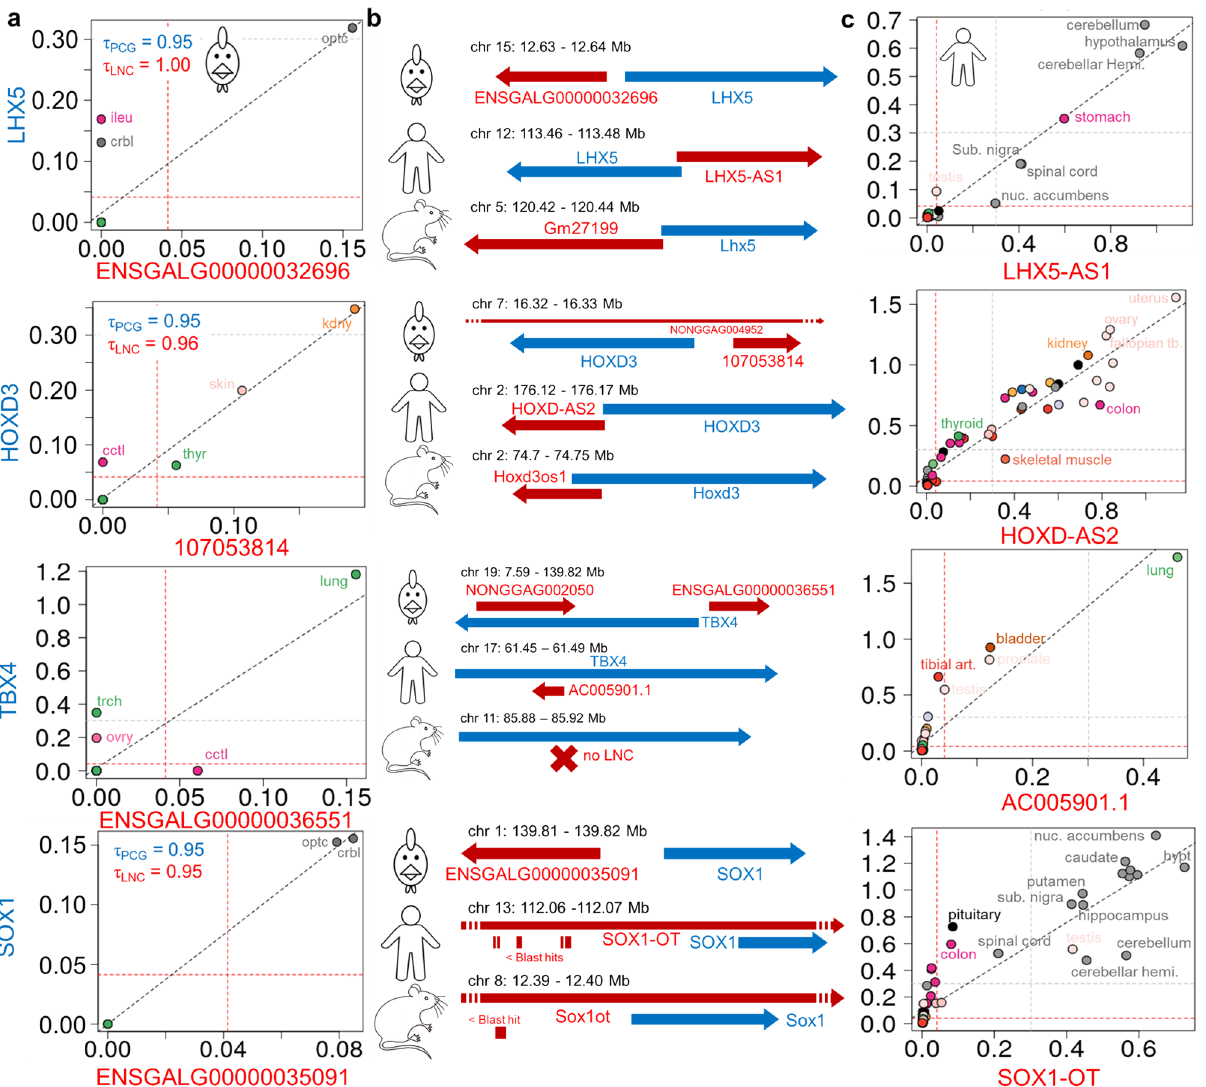
Figure 6. Tissue expression in chicken ( a ) and human ( c ) for 4 LNC:PCG pairs with similar genomic configurations between the two species ( b ). ( a ) Log 10 (TPM + 1) expression of the LNC (X-axis) and the PCG (Y-axis) (top) for chicken across the 21 tissues of the 21 T dataset for the four chicken divergent pairs for which both members are tissue-specific in the same tissue. ( b ) Genomic configuration in three species of the LNC:PCG pairs. In red the LNC, in blue the PCG. For the LNC:SOX1 pair, were added the positions of hits (in minus strand) resulting in the mapping of ENSGALG00000035091 chicken LNC sequences to human and mouse genome on the opposite strand. ( c ) Expression in log 10 (TPM + 1) of LNC:PCG pairs in 53 human tissues using the GTEx data. Tissues abbreviations are the same as in Fig.